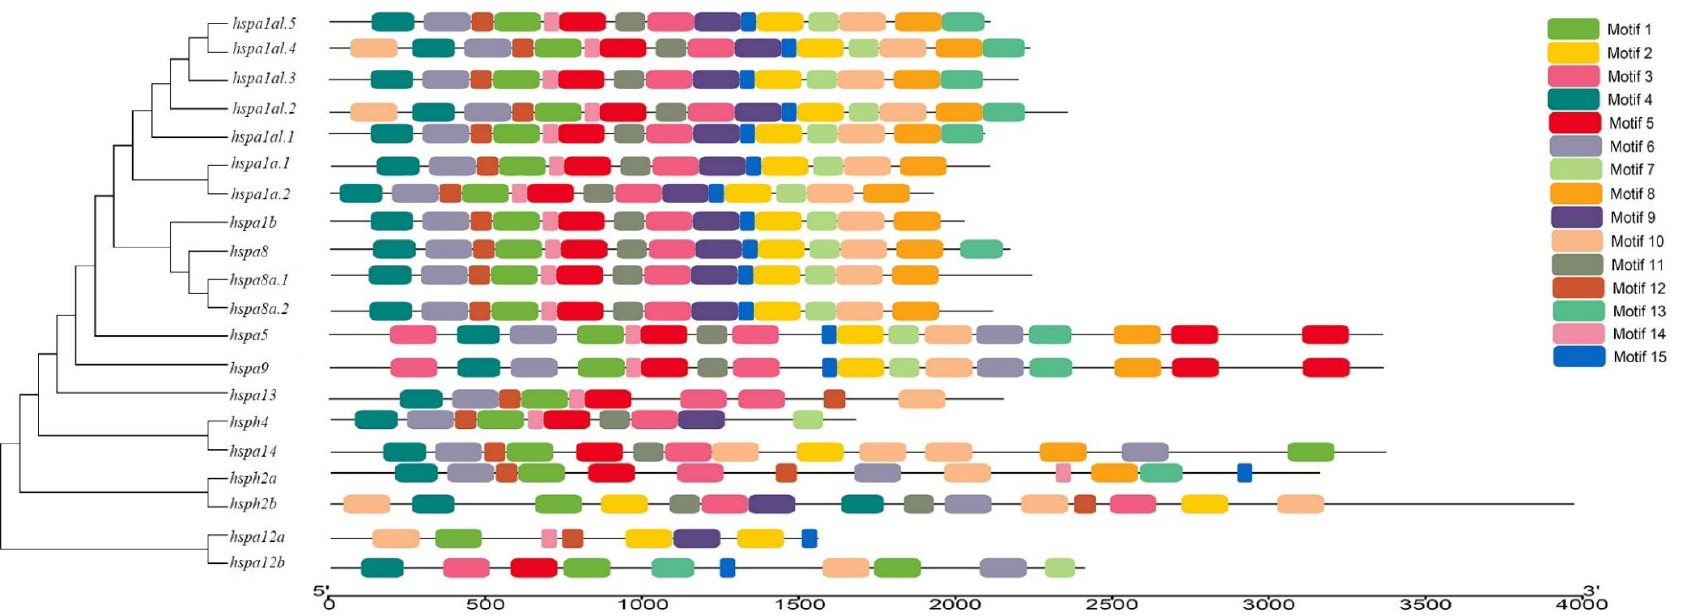
Figure 3. The conserved motifs of B. pectinirostris Hsp70s according to phylogenetic relationship. All motifs are identified by MEME database with the complete nucleotide sequences of B. pectinirostris Hsp70s. Each colored box represents a motif detected in the corresponding sequence. MEME: Multiple Expectation Maximization for Motif Elicitation